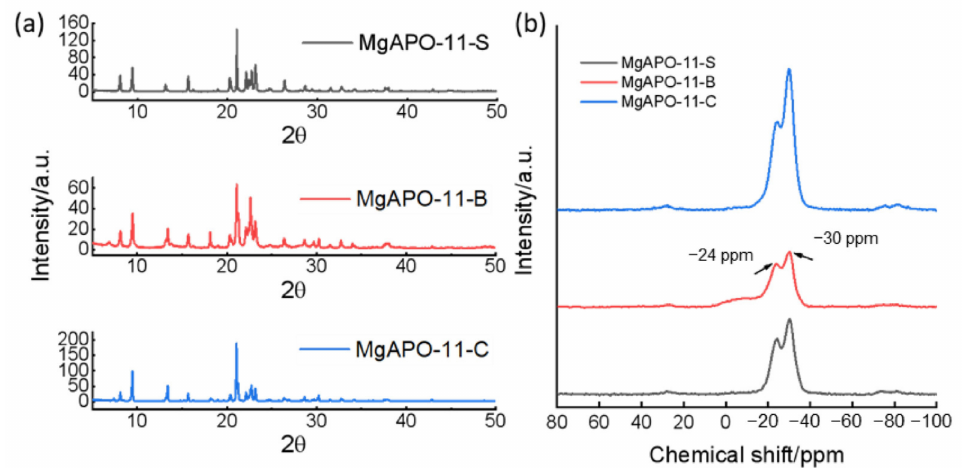
Figure 2. PXRD and MAS NMR data for MgAPO-11 Samples ( a ) PXRD patterns and ( b ) 31 P MAS NMR of the three MgAPO-11 samples.